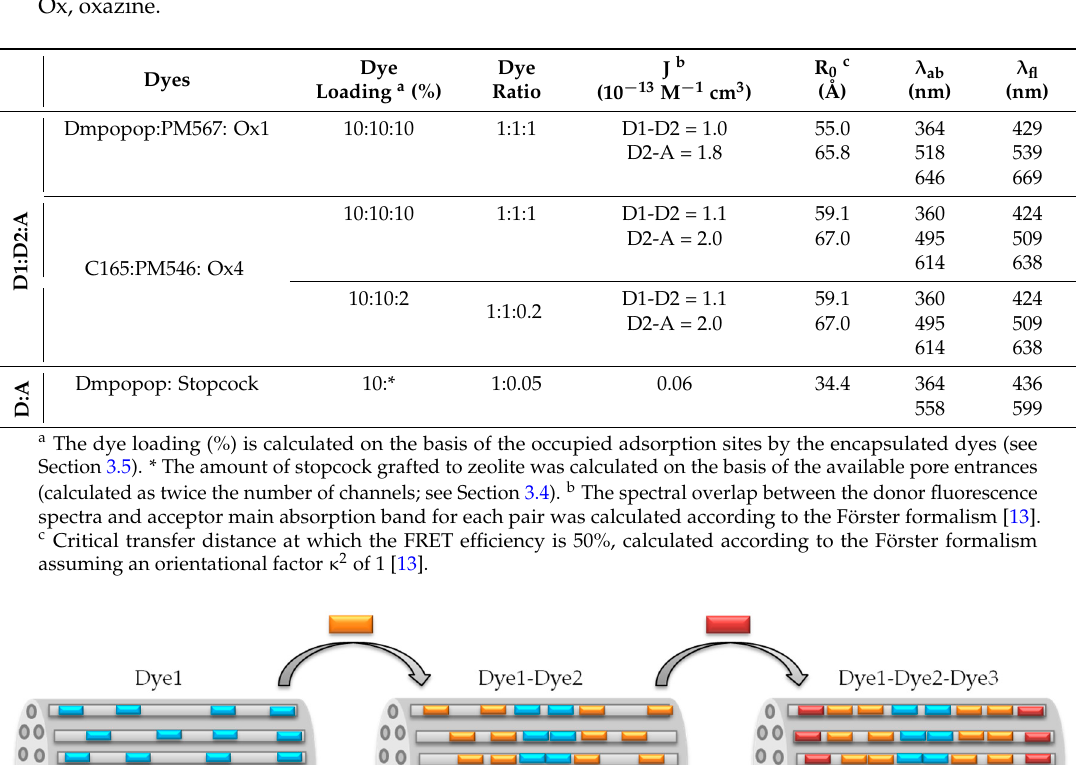
Table 1. Meaningful data about dye loadings, spectral band positions and the ongoing FRET between the dyes occluded or anchored into the disc-shaped LTL zeolite: dye loadings, donor-acceptor ratio, spectral overlap (J), absorption ( λ ab ) and fluorescence ( λ fl ) peak wavelengths. C165, carbostyril; Ox, oxazine.